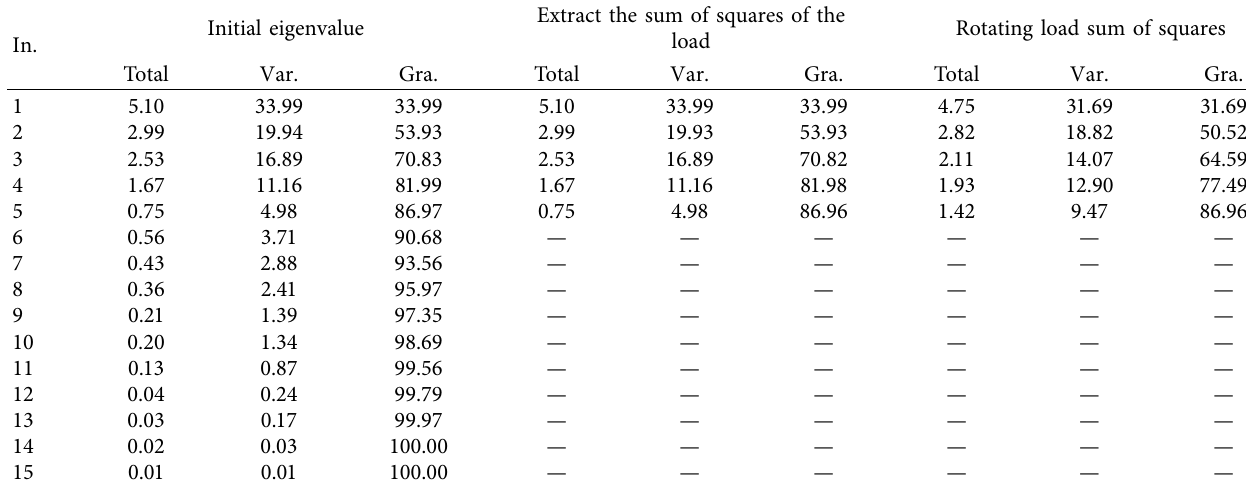
Table 4: Principal component extraction analysis of total variance explanation.